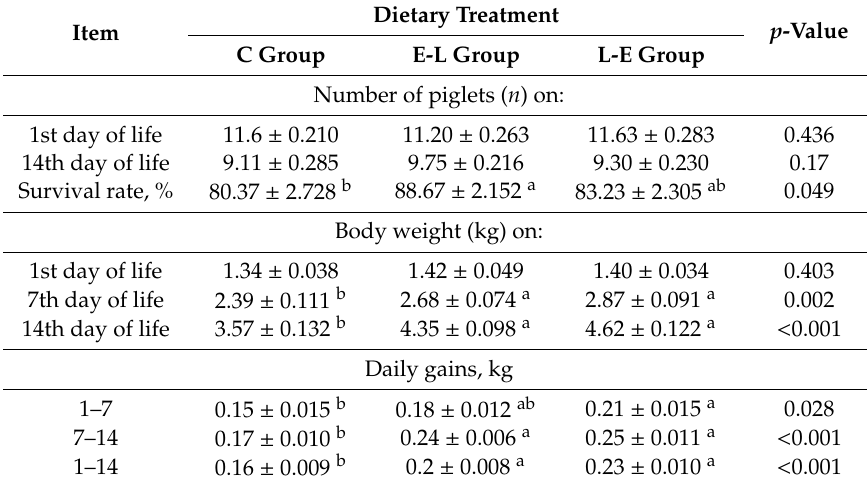
Table 6. Growth performance of suckling piglets ( n = 20).